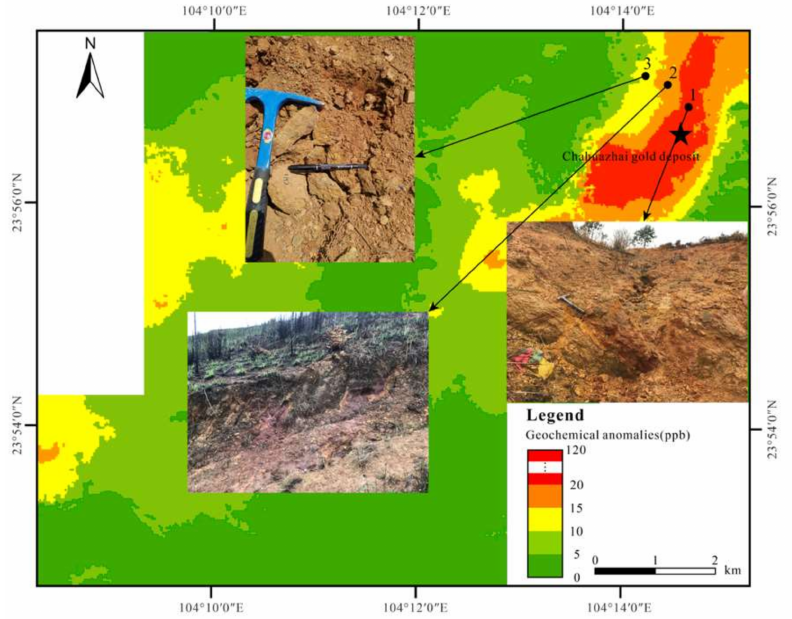
Figure 15. Testing field soil sample